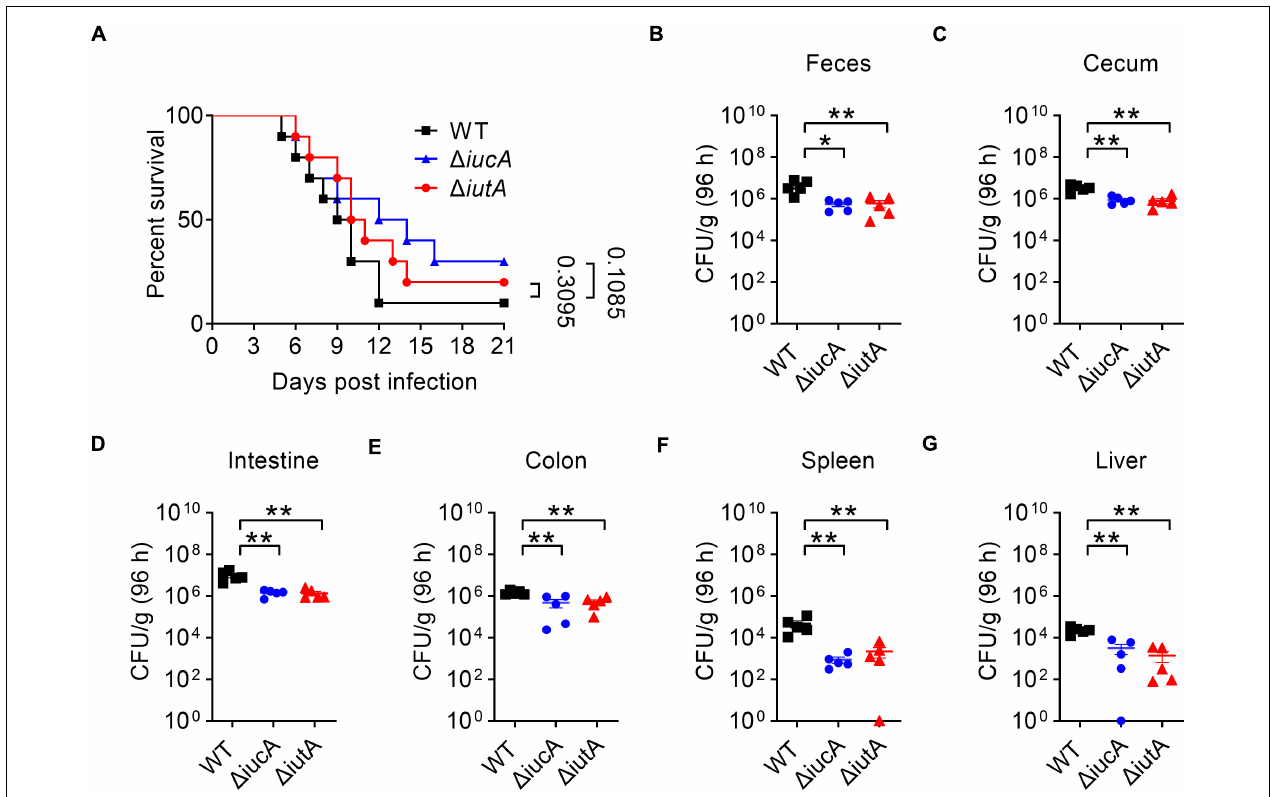
FIGURE 6 | Aerobactin-mediated active iron acquisition contributes to the pathogenicity of Y. pseudotuberculosis . Relevant Y. pseudotuberculosis strains grown in YLB were washed twice in sterilized PBS and used for orogastric infection of 6- to 7-week-old female C57BL/6 mice using a ball-tipped feeding needle. For survival assays, 1 × 10 9 bacteria of each strain were applied to different groups of mice ( n = 10/strain), and the survival rate of the mice was determined by monitoring the survival daily for 3 weeks (A) . Enumeration of bacterial burdens in the feces (B) , cecum (C) , intestine (D) , colon (E) , spleen (F) , and liver (G) of infected C57BL/6 mice at 3 days post-infection by CFU assays ( n = 5). Similar results were obtained in three independent experiments, and data shown are from one representative experiment done in triplicate (A). Statistical analyses were performed by Log-Rank test (A) . The statistical significances were determined by the Mann–Whitney test (B–G) . * p < 0.05; ** p <